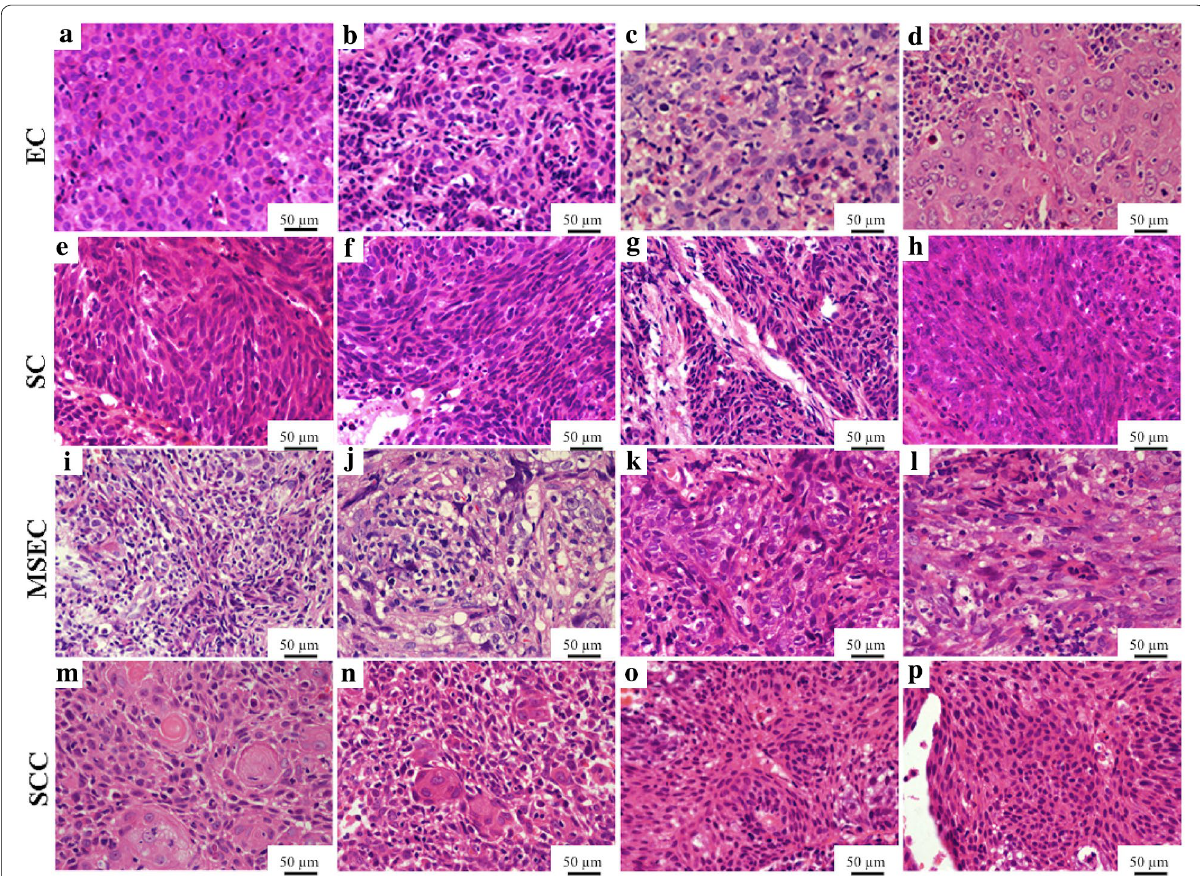
Fig. 2 Representative morphologic traits of tumors according to the proposed classification of NPC (H&E, 400). The epithelial carcinoma (EC) × subtype shows small, round cells with cellular stratification and a pavement‑like appearance, a low nucleus:cytoplasm ratio, chromatin‑rich nuclei ( a ), and non‑prominent nucleoli ( b ); or syncytial‑appearing large tumor cells with indistinct cell borders, round‑to‑oval vesicular nuclei, and large central nucleoli ( c ); a round shape with vesicular nuclei and prominent nucleoli accounting for more than 75% of tumor cells ( d ). The sarcomatoid carcinoma (SC) subtype features irregular small cells, large hyperchromatic cells, or both, or uniformly medium‑sized spindle cells ( e ), together with nucleoli that are less prominent than those in the syncytial‑appearing cells ( f ), dark, smudged nuclei and a dense amphophilic ( g ), or eosinophilic cytoplasm ( h ). The mixed sarcomatoid‑epithelial carcinoma (MSEC) subtype is characterized by large, round cell nests ( i ) or scattered infiltration of large, round cells in the spindle cell carcinomatous tissue ( j ); no obvious boundaries were observed between the tumor and interstitial lymphoid tissue ( k ) or in the stromal portion that contained cells with eosinophilic cytoplasm ( l ). The squamous cell carcinoma (SCC) subtype shows well differentiated keratinizing SCC with a large number of whorls ( m ) and keratin ( n ), or poorly or moderately differentiated SCC with some individual keratinized spine cells ( o ) and a small number of basal‑like cells ( p